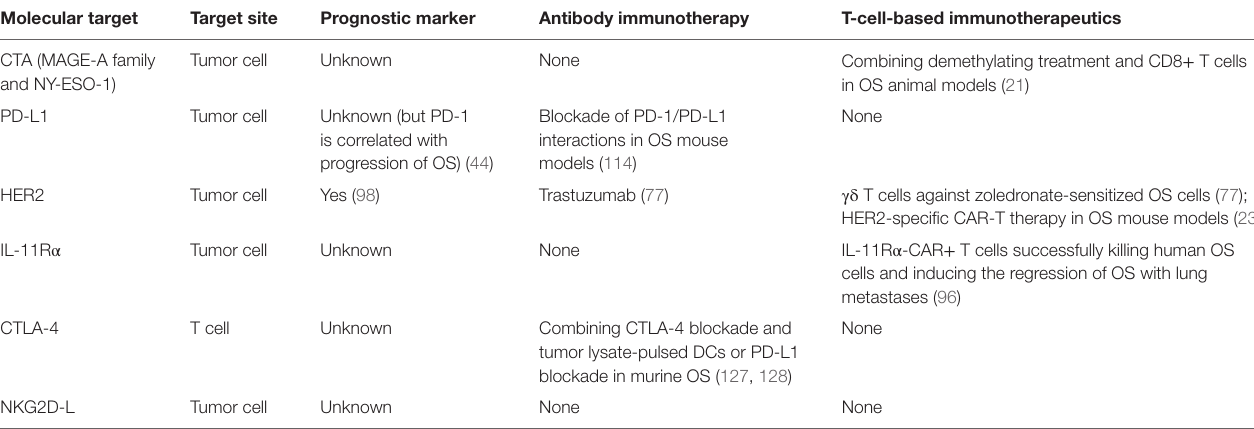
TABLe 3 | Promising molecular targets for OS